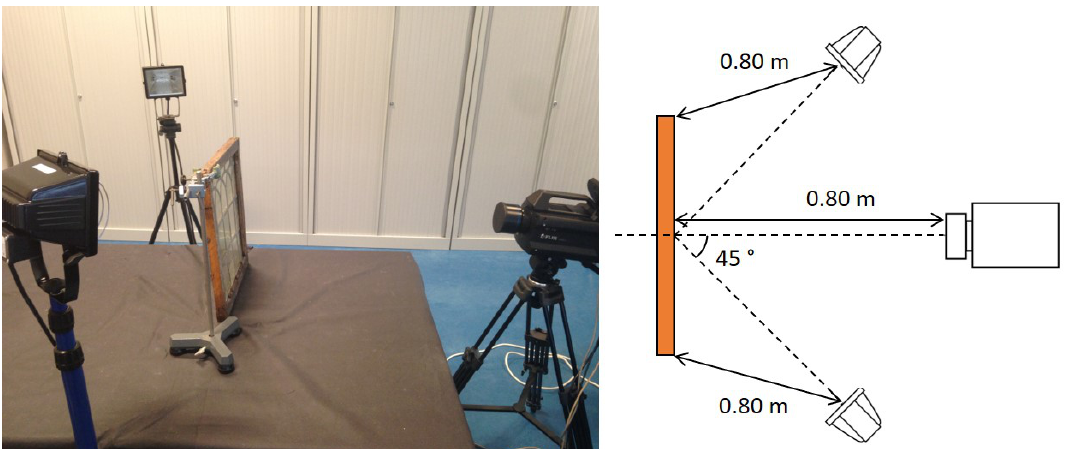
Figure 2. Experimental setup with the camera facing the interior side of the window. Left: The heat sources are placed in transmission mode. Right: the heat sources are placed in reflection